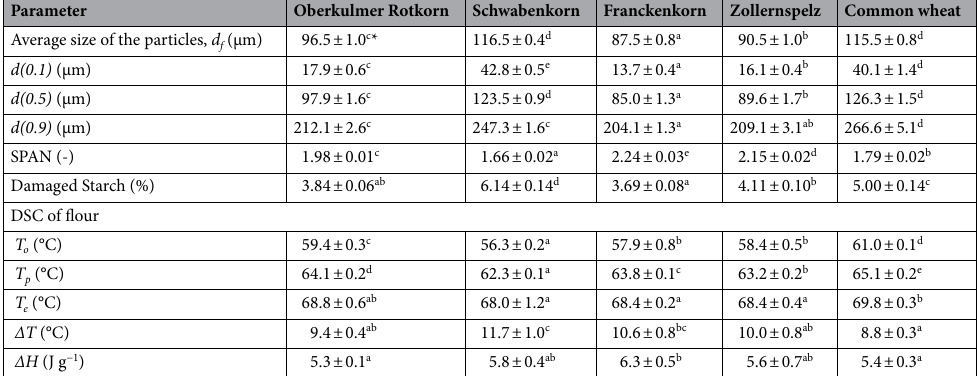
Table 4. Physical properties of spelt and common wheat flour. *Values given as the average values ± standard deviation (SD). Values marked with the same letters in rows are not significantly different at p ≤